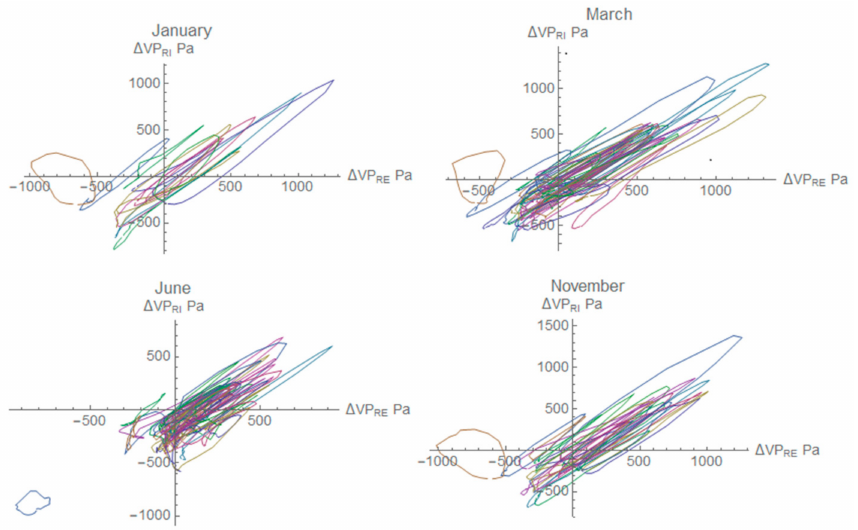
Figure 13. Water vapour pressure difference as in Figure 12 for a greater number of dwellings from the Pilot Housing Survey for the months of January, March, June and